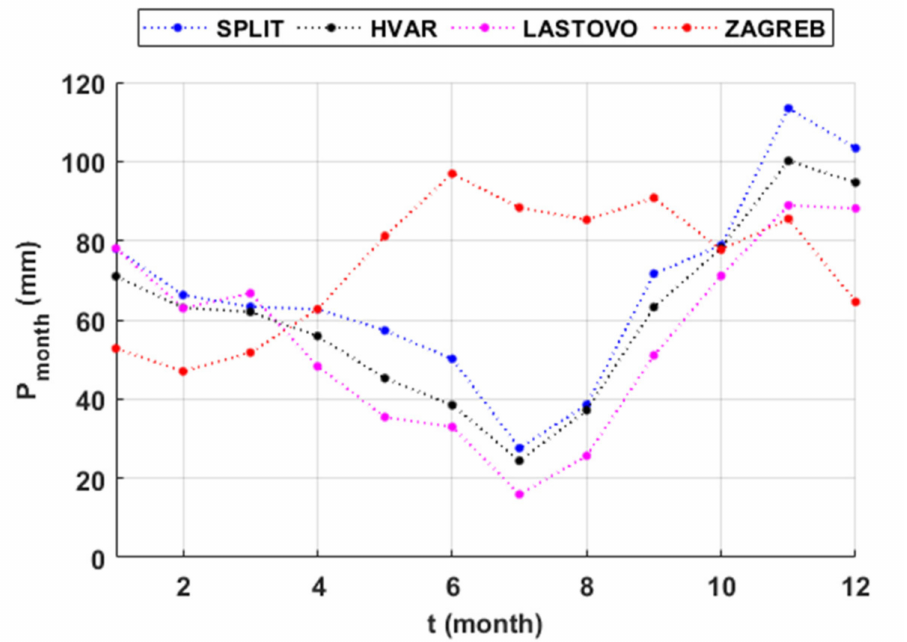
Figure 8. Graphical presentation of average monthly precipitations measured at the four analysed stations during the 1948–2020